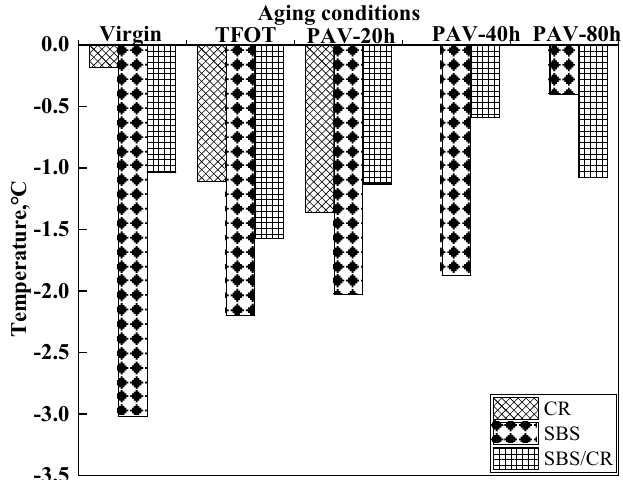
Figure 10. PG Low temperature difference of tested binders.